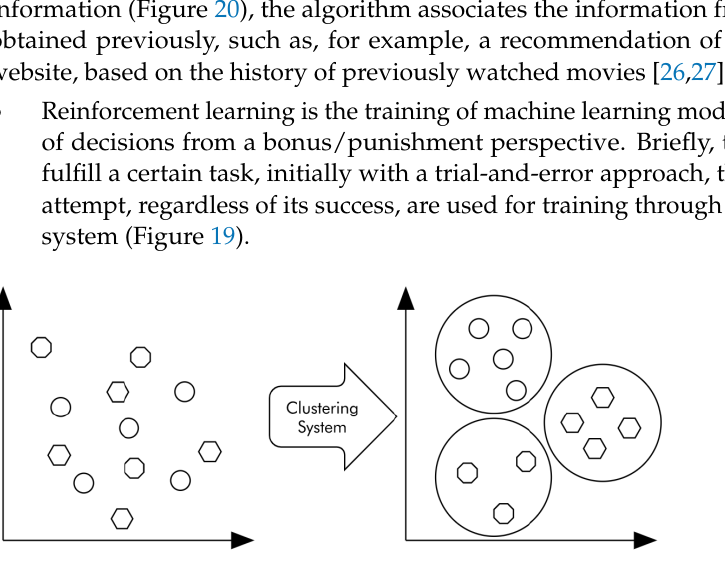
Figure 19. Unsupervised learning – Information extraction (Adapted from [28]).